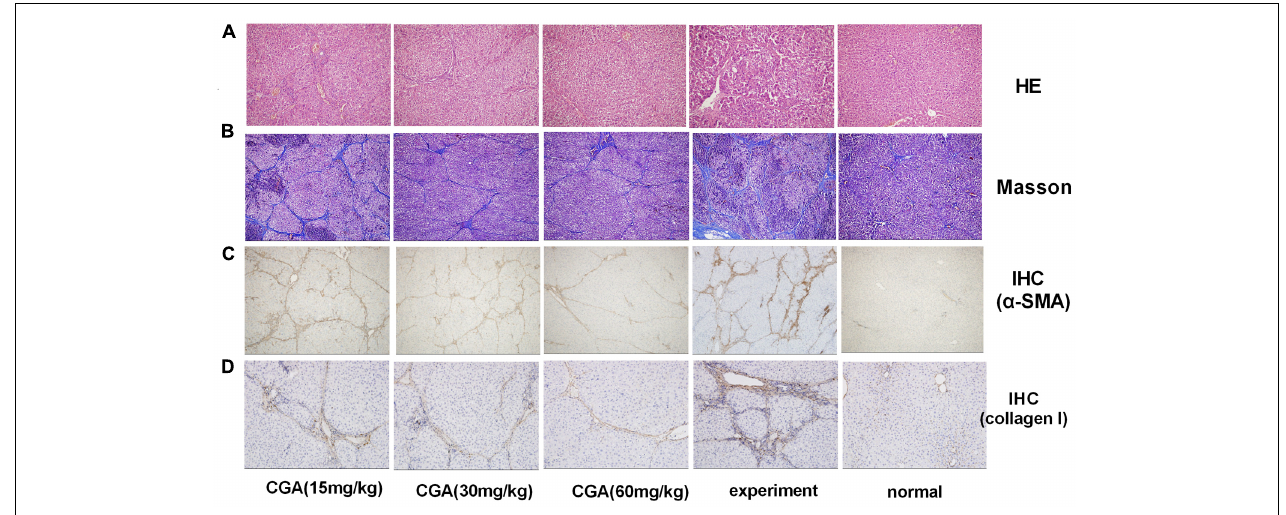
FIGURE 9 | Evaluation of the effect of CGA on liver histopathological and immunohistochemistry (IHC) in liver tissue. (A) Histological images of rat livers stained with H&E (original magnification, × 200). (B) The histopathologic detection of collagen in the liver by Masson’s trichrome stain (original magnification, × 100). (C,D) Effects of CGA on α -SMA and collagen I expression were examined with immunohistochemistry in liver tissue (original magnification, × 100).